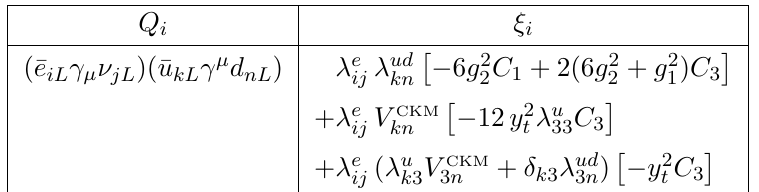
Table 5 . Operators Q i and coe(cid:14)cients (cid:24) i for the semileptonic part of the e(cid:11)ective Lagrangian L EW involving charged currents. For up-type quarks the indices run from 1 to 2. The (cid:24) i coe(cid:14)cient for the Hermitian conjugate operator can be easily derived.